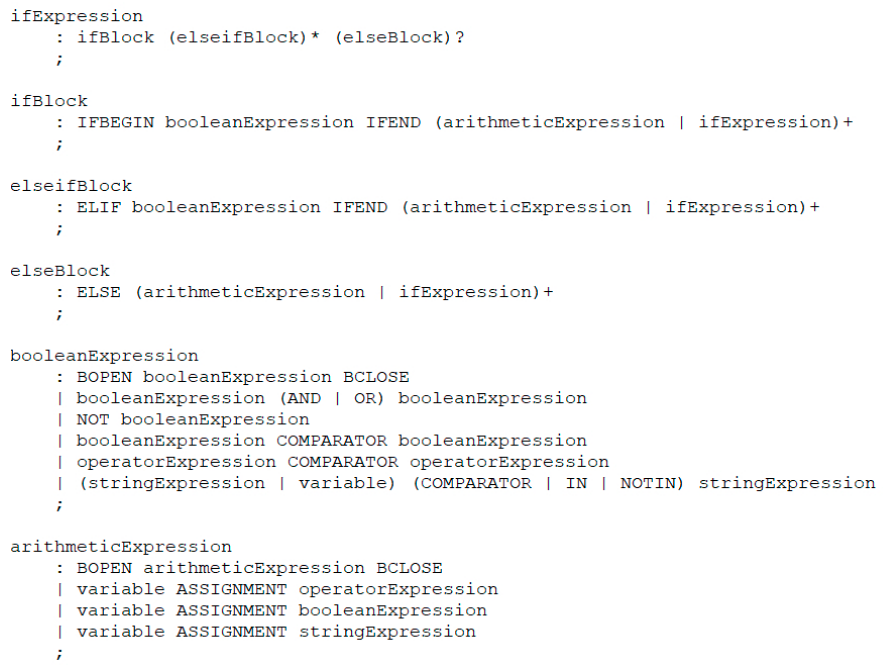
Figure 10. Excerpt from the context free grammar used to analyze the port dependencies.